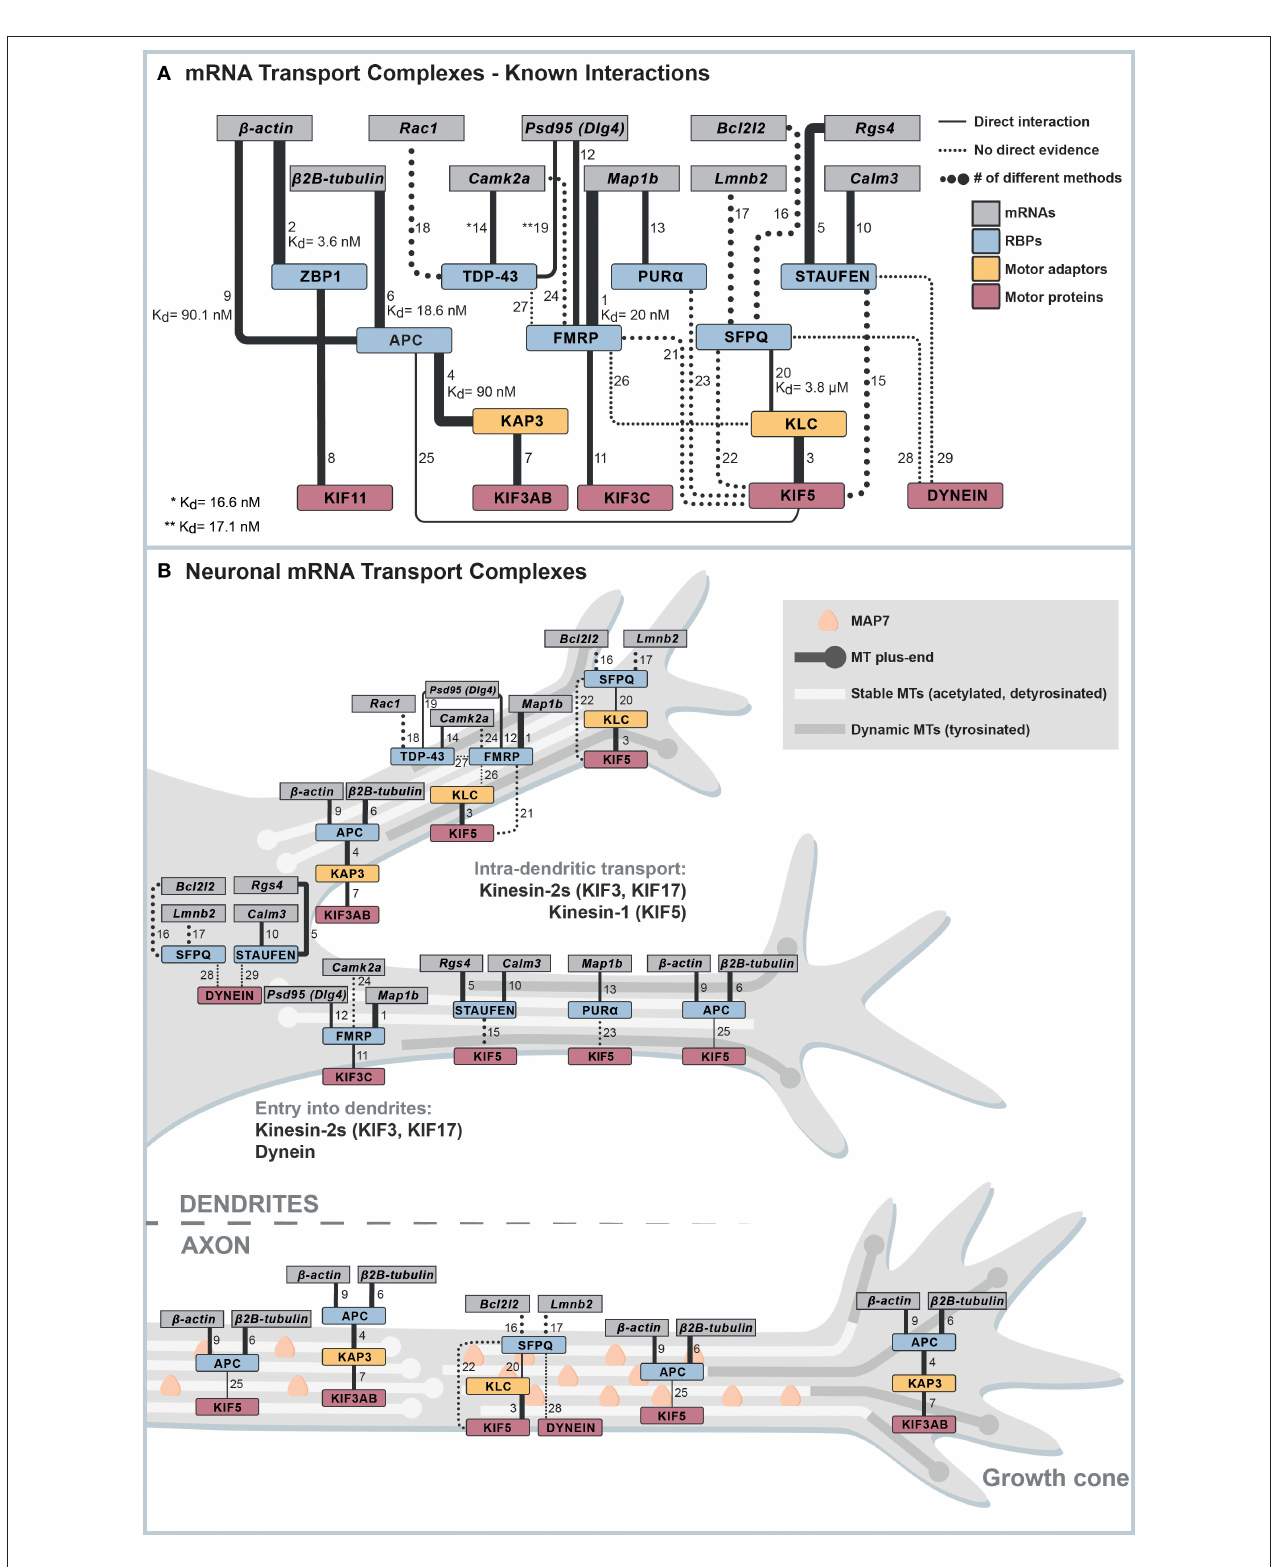
FIGURE 1 | Known interactions linking mRNAs to motor proteins. (A) Cytoscape network of known interactions. The network summarizes and weighs available evidence that allows the establishment of connections between mRNAs and microtubule motor proteins. Only evidence from low-throughput techniques is shown,